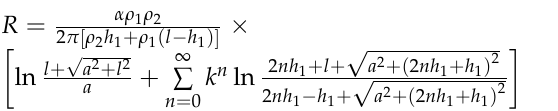
R Figure 4. Conical antenna model of an offshore WT tower. The wave impedance of the differential element dh Z ’ can be obtained from the cone antenna theory, as shown in Equation (11):